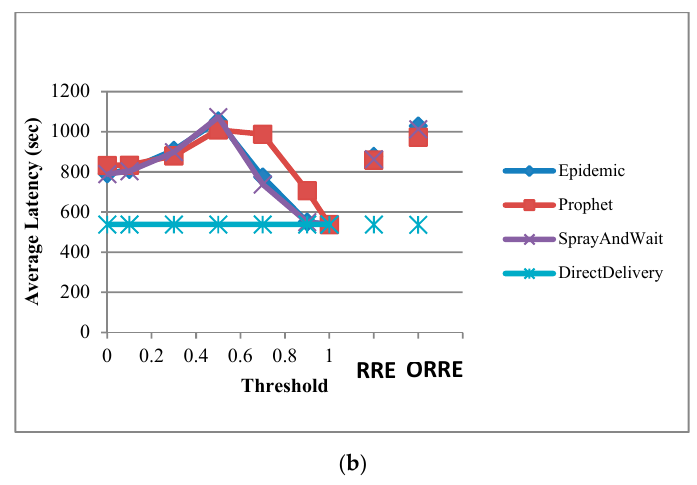
Figure 6. Average latency for Threshold, RRE, ORRE for ( a ) pigeon and ( b ) flying fox scenarios.